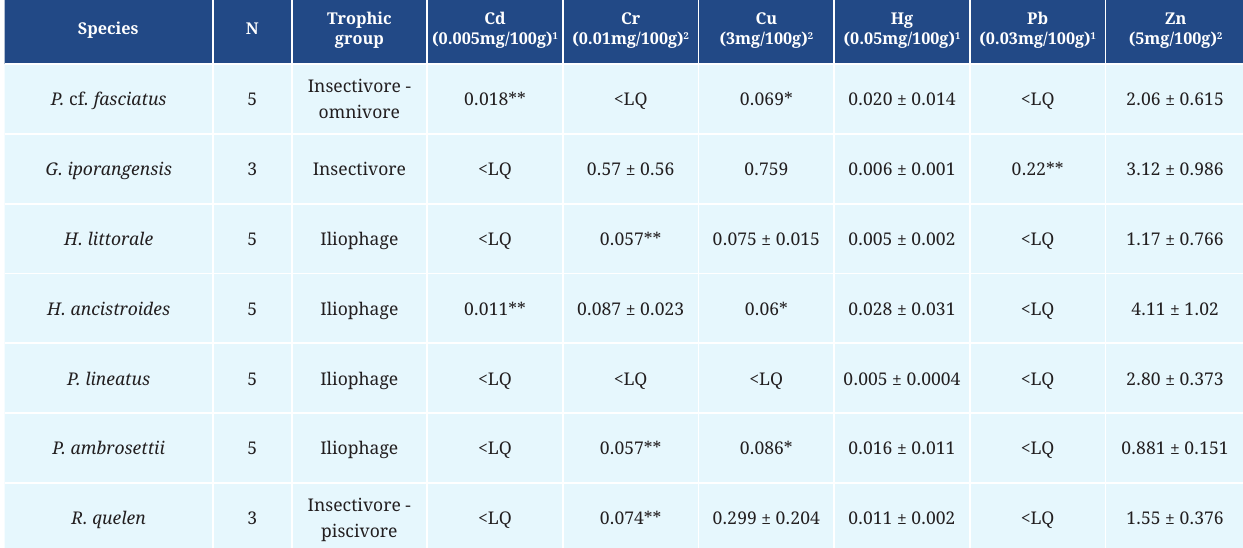
TABLE 3 | Concentration (mg/100g) of metals considered in the study, for fish muscle samples from the Sorocaba River. N: Number of analyzed samples; LQ: Limit of Quantification (Cd- 0.0250 mg/100 g. Cr-0.025 mg/100 g. Cu- 0.025 mg/100 g. Hg- 0.001 mg/100 g. Pb- 0.025 mg/100 g.